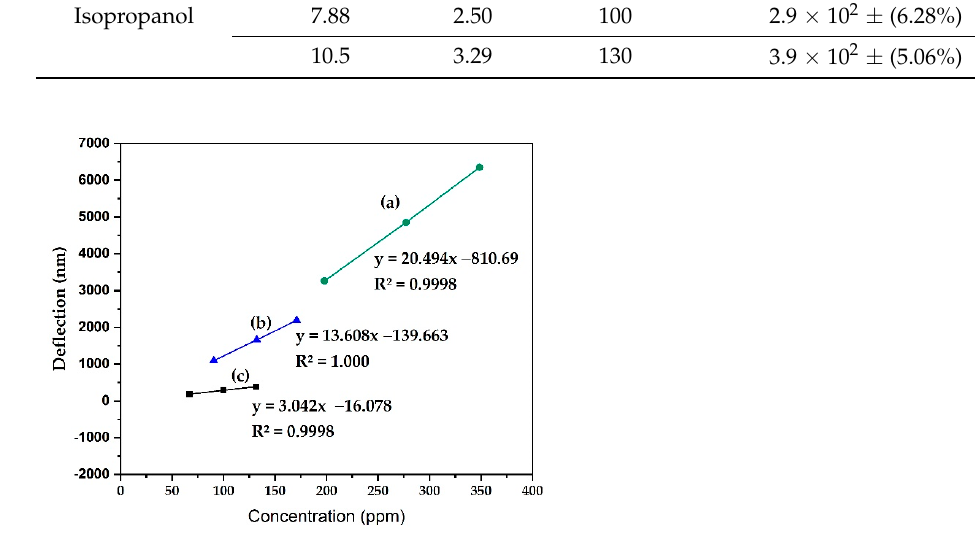
Figure 4. Concentration vs. deflection plots of the PMMA-coated MCLs to the (a) methanol (MeOH); (b) ethanol (EtOH) and (c) isopropanol (IPA) vapor.